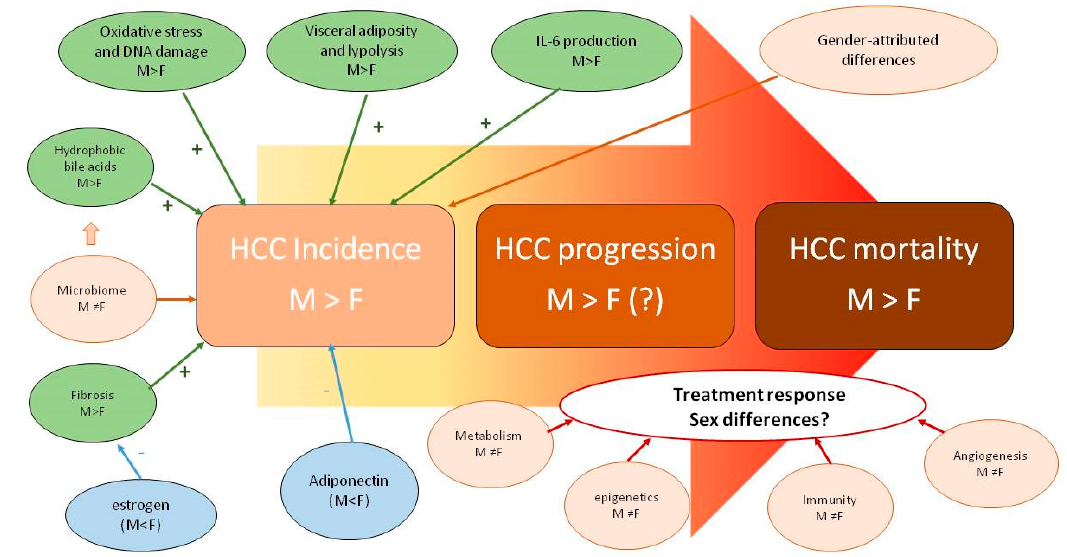
Figure 1. Sex disparity in pathobiology, epidemiology and clinical features of HCC [reprinted from 53].